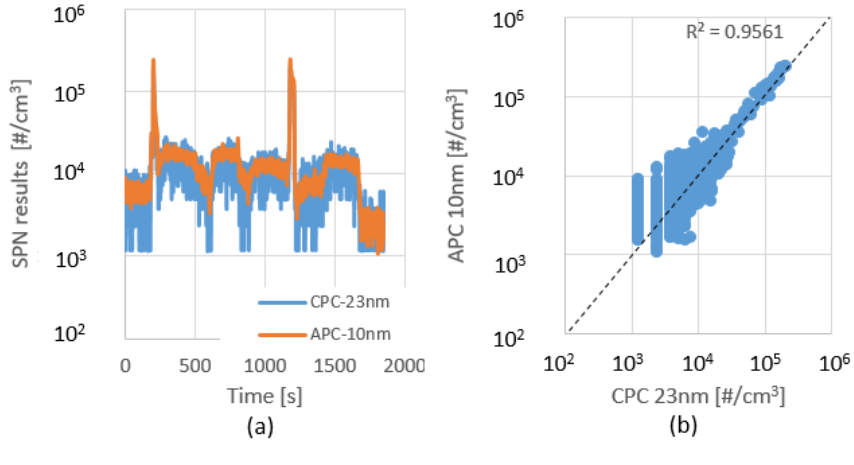
Figure 8. Calculated solid particle number results of each individual test, without DPF.